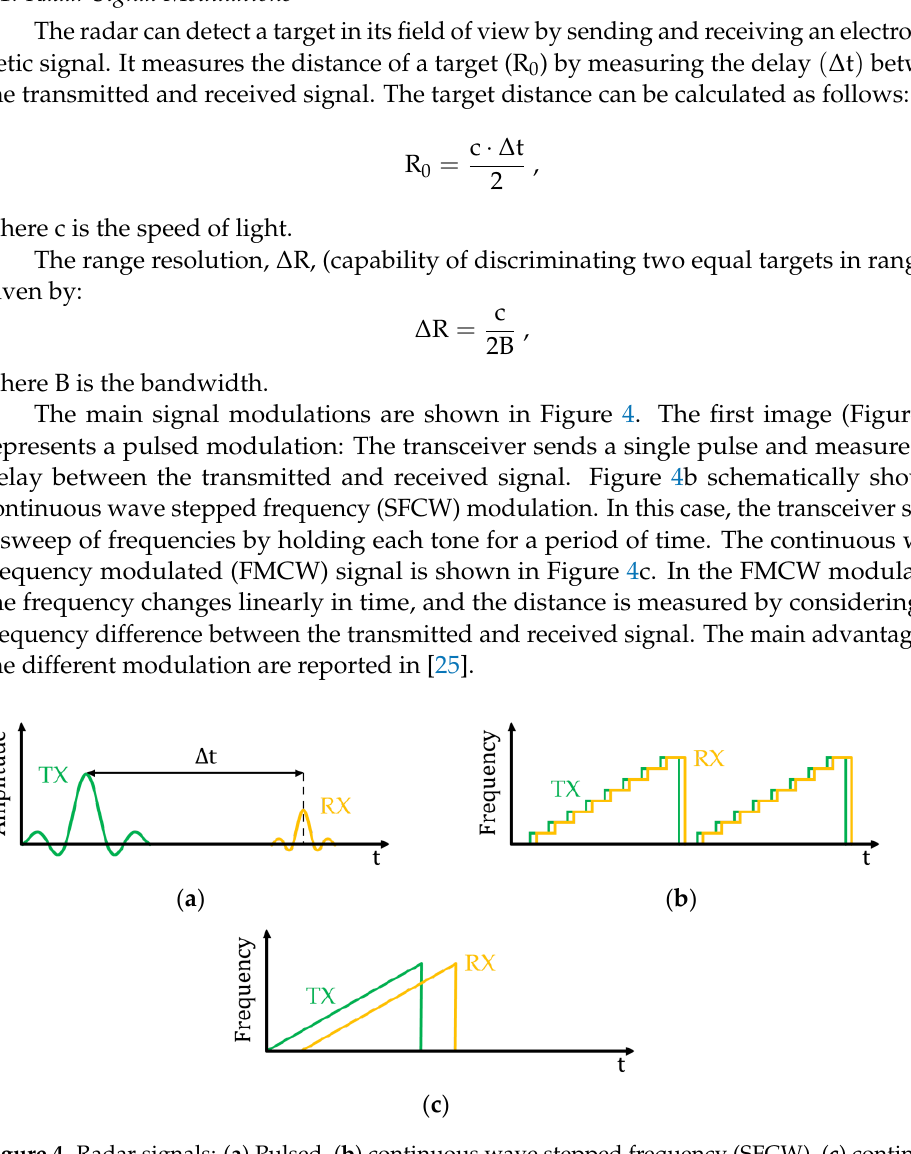
Figure 4. Radar signals: ( a ) Pulsed, ( b ) continuous wave stepped frequency (SFCW), ( c ) continuous wave frequency modulated (FMCW).